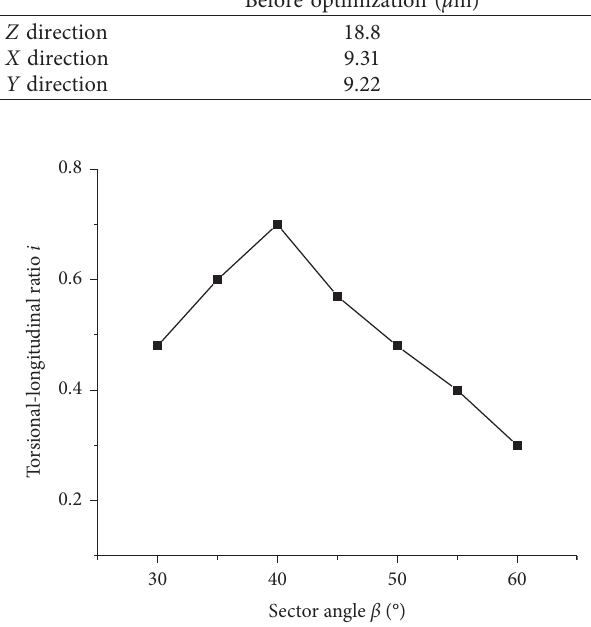
Figure 13: The effect of sector angle β of spiral groove on torsional- longitudinal ratio i .